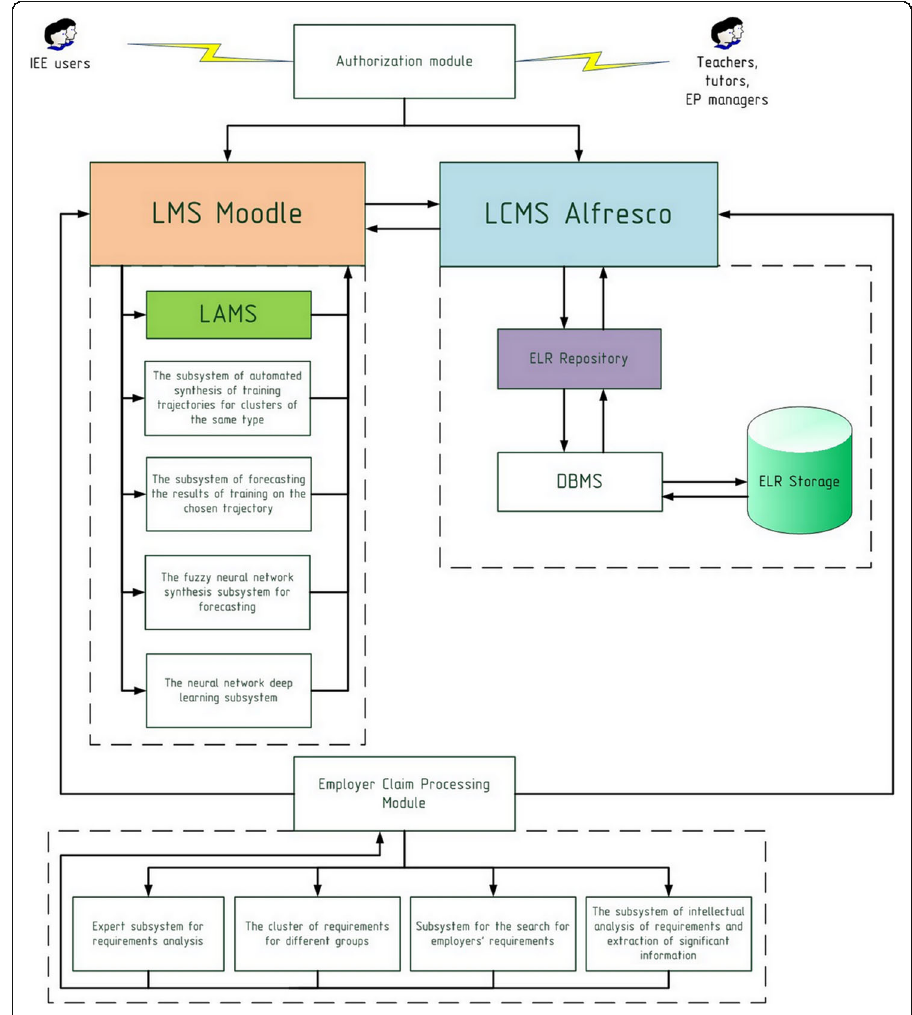
Fig. 6 The smart learning environment ’ s